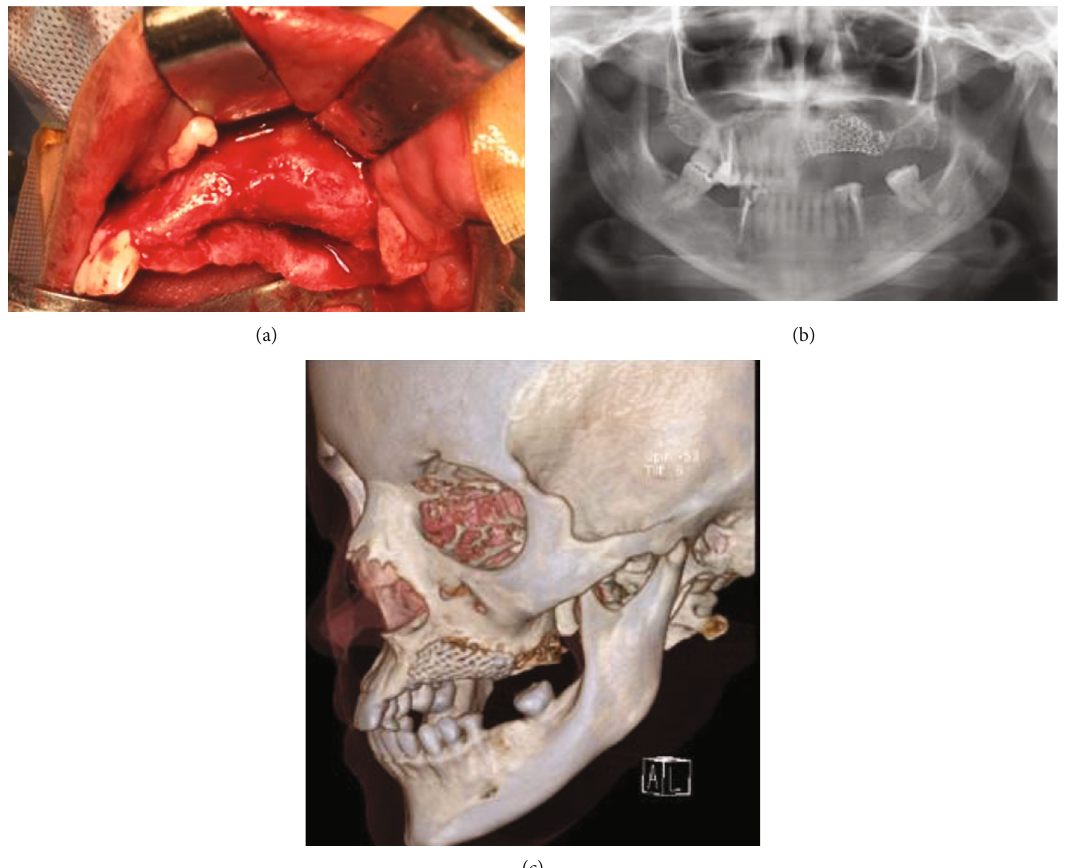
Figure 3: (a) Photographs showing the postoperative view of the maxillary defect. (b, c) Postoperative computed tomography and radiographic